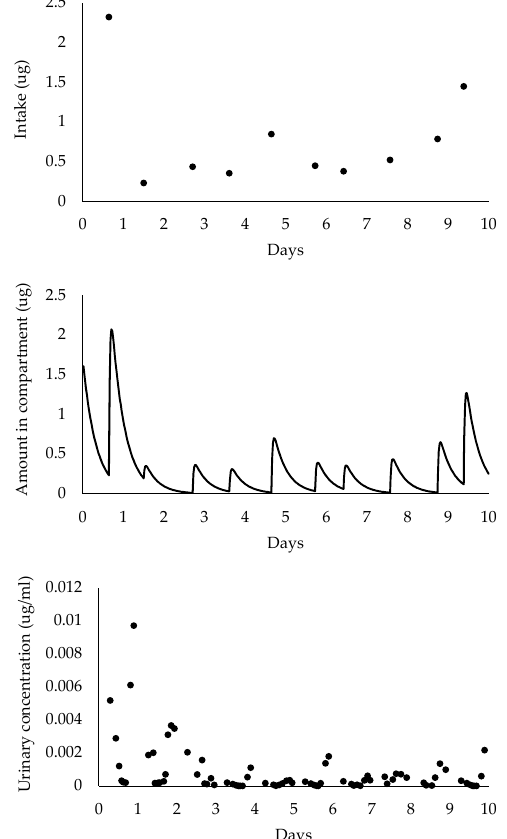
Figure 2. Simulated intake, amount in central compartment, and urinary concentrations over the course of 10 days for one individual exposed to a chemical with a half-life of 4 hours once a day at random times. Of note, model inputs are those presented in Figure